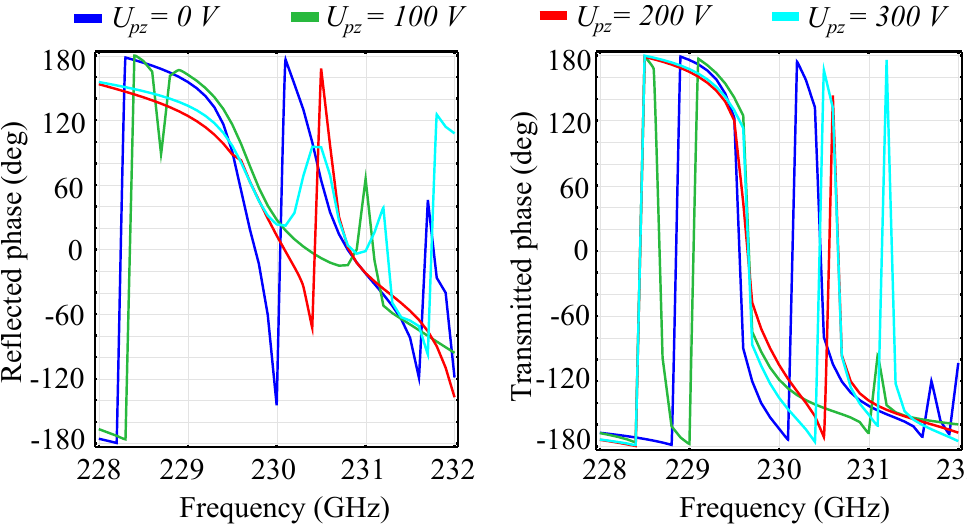
Figure 11. Simulated phase of the reflected and transmitted waves associated to the piezoelectric voltages applied longitudinally across the unit cell in the silica glass substrate unit cell